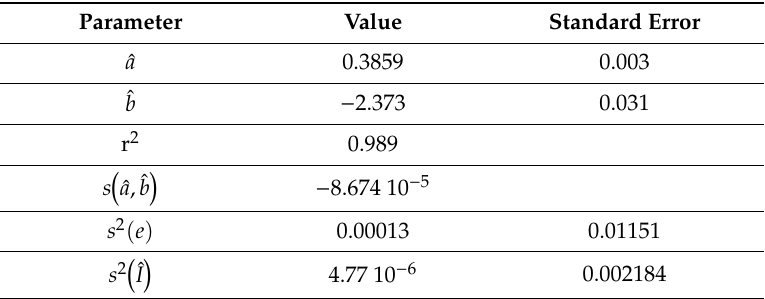
Table 2. Calibration parameters and statistics of linear